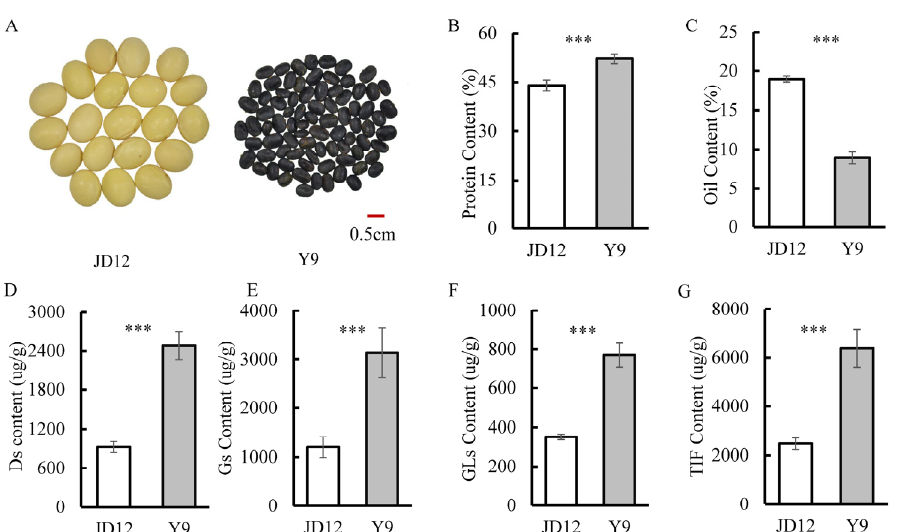
Figure 1. Comparison of quality and isoflavone traits between JD12 and Y9. ( A ) Photo of JD12 and Y9 seeds. ( B ) Protein content. ( C ) Oil content. ( D ) Content of daidzein isoflavone derivatives (Ds). ( E ) Content of genistein isoflavone derivatives (Gs). ( F ) Content of glycitein isoflavone derivatives (GLs). ( G ) Total isoflavone content (TIF). Bars represent means ± SDs from six replications. Asterisks indicate the significance of differences between JD12 and J9 as determined by the Student’s t -test at a 0.001 (***) significance level.